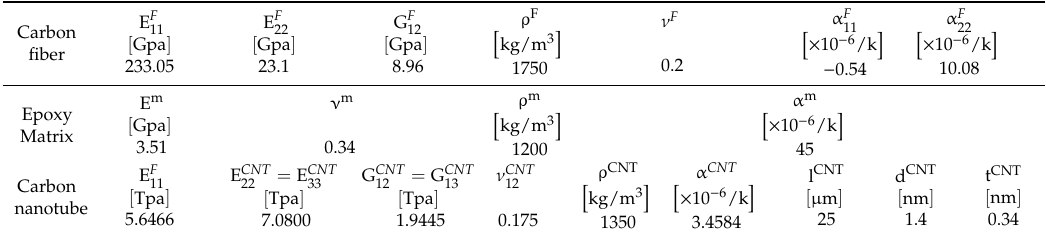
Table 1. Material properties of the multiscale hybrid nanocomposite annular plate [64].